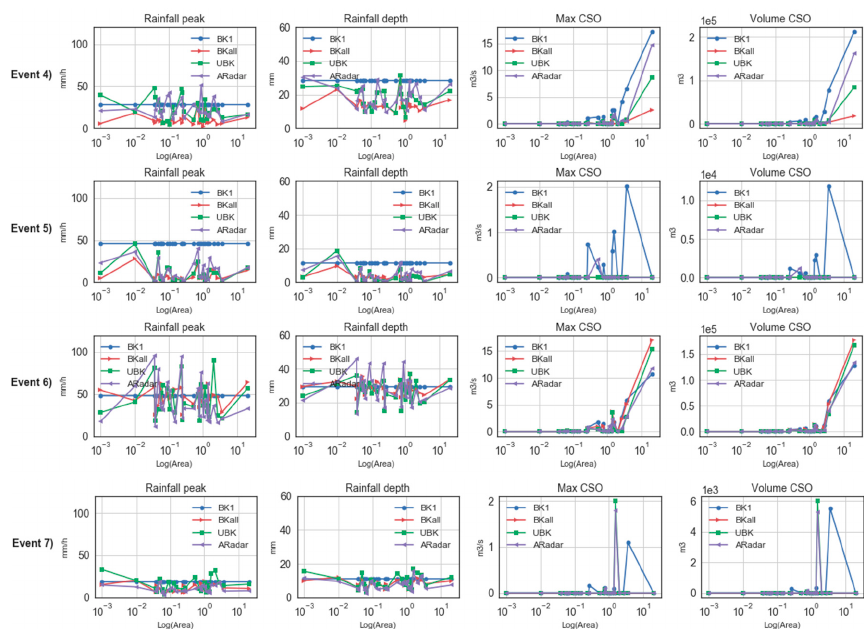
Figure 6. By-catchment response to rainfall spatial information for the 10-min temporal-accumulated product (catchments are represented on the x axis by their connected area in km 2 ).